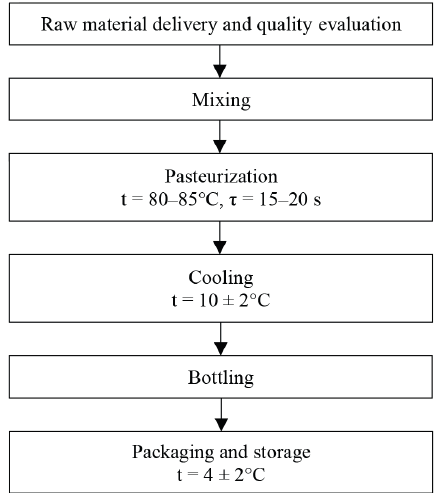
Figure 6 Flow chart for the whey drink fortified with biologi- cally active substances extracted from Rhodiola rosea L.